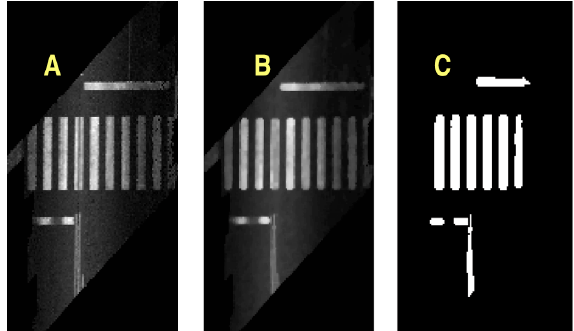
Figure 6. Image processing to detect reflective painted marks. A intensity image; b) filtered image using median filter; c) binary image using the Otsu method.